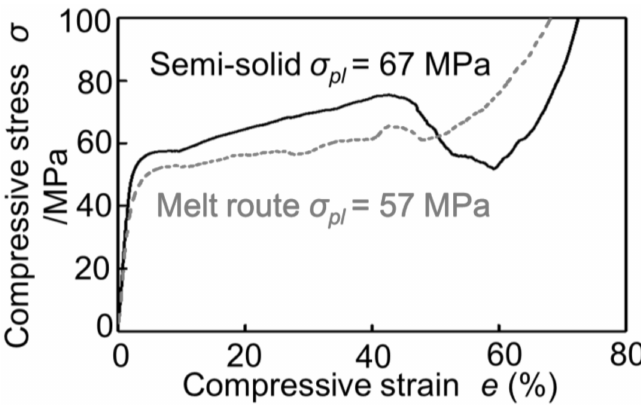
Figure 2. Stress–strain curves (porosity about p = 60%) of Melt-A2024 and